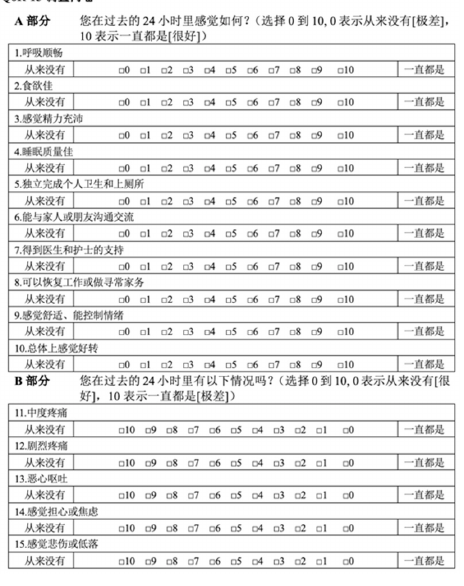
Figure A1. The Chinese Version of the Quality of Recovery—15 Score.